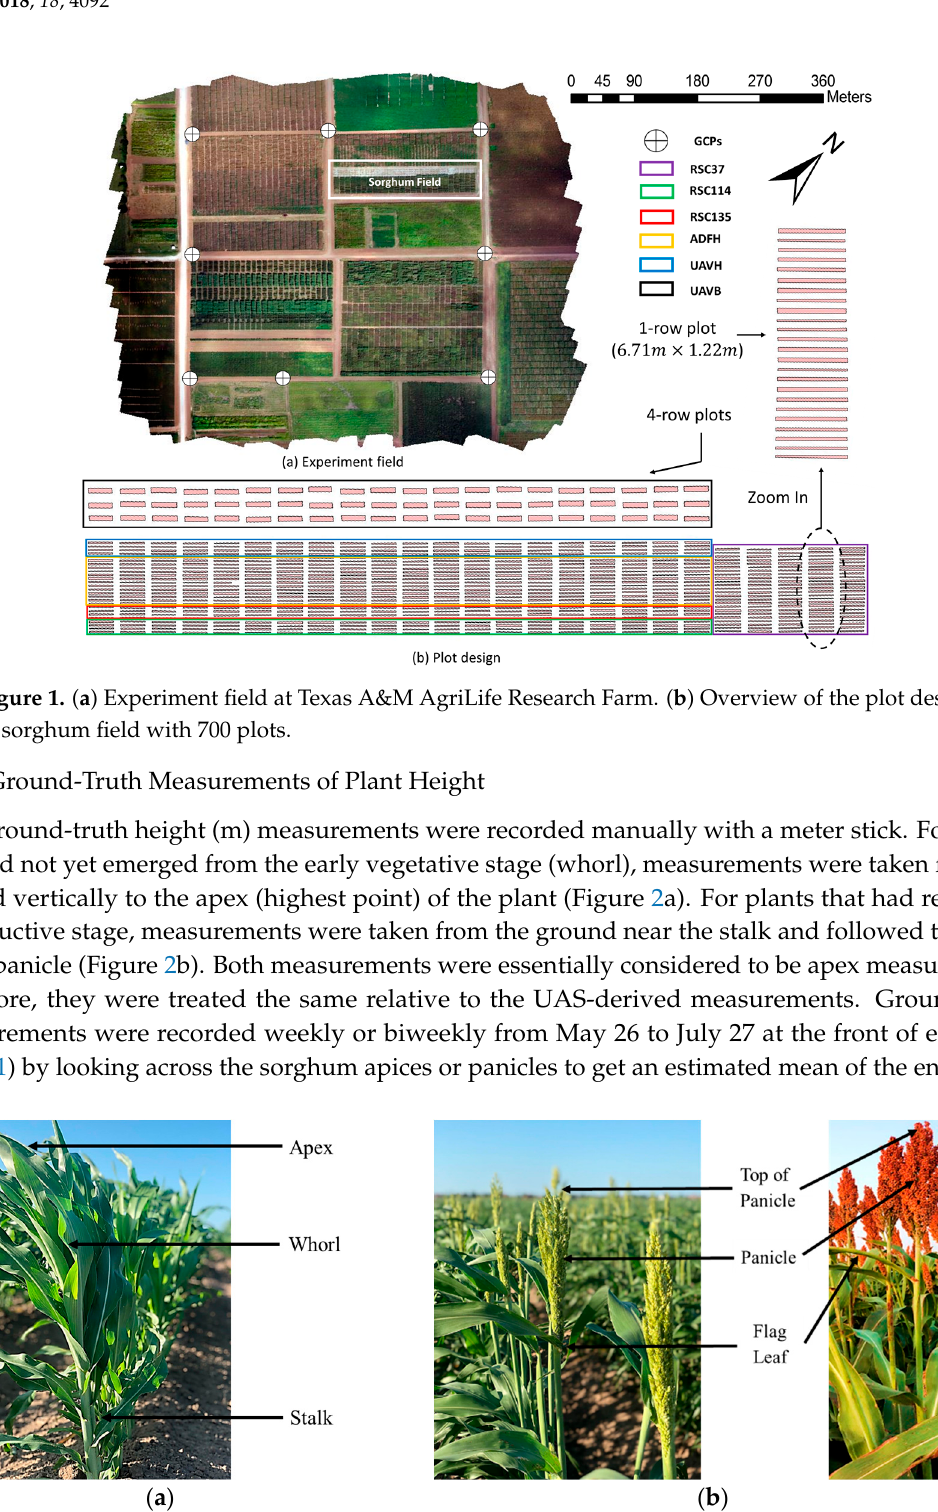
Figure 2. Ground truth measurement of plant height at two different growth stages (Photo Credit: Kayla Brock). ( a ) Vegetative stage. ( b ) Reproductive stage. Table 1. UAV fl ights with corresponding fi eld plant height measurements.